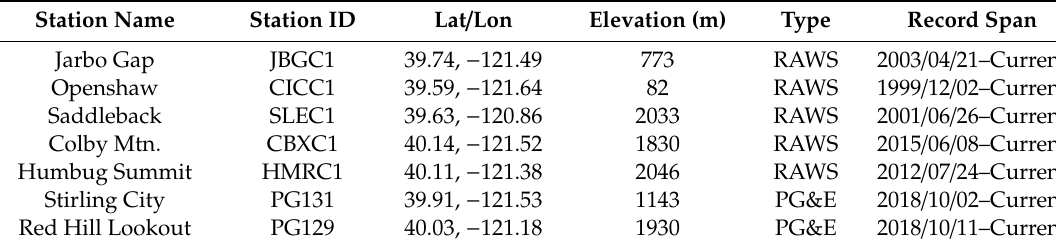
Table 1. Description of weather stations used in this